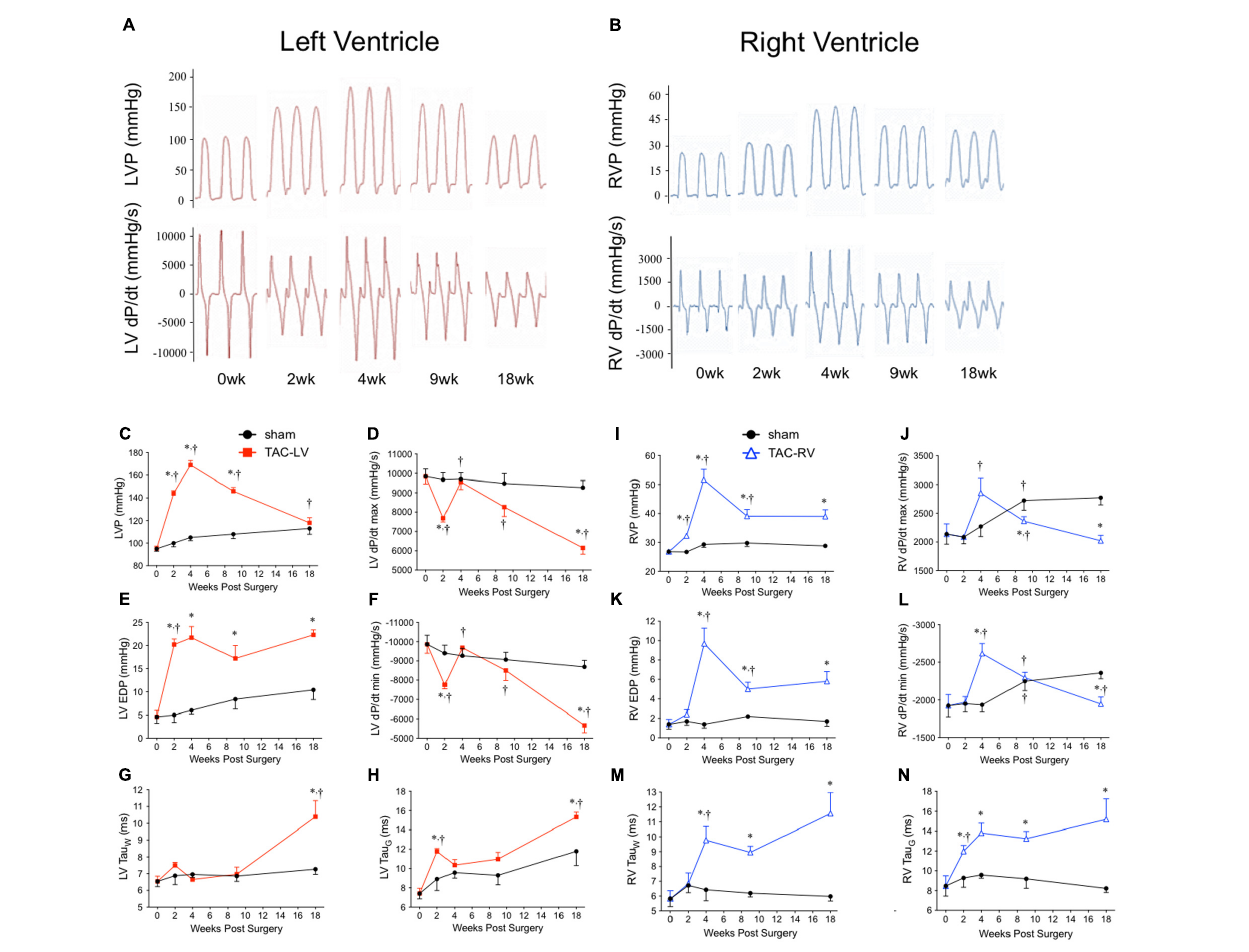
FIGURE 1 | Hemodynamic characterization of the transverse aortic constriction (TAC) model in male CD1 mice over 18 weeks. Left panel (red) = left ventricular (LV) function. Right panel (blue) = right ventricular (RV) function. Representative hemodynamic tracings over 18 weeks from (A) the LV and (B) the RV. (C) Peak LV pressure (LVP), (D) LV dP/dt max , (E) left ventricular end diastolic pressure (LV EDP), (F) LV dP/dt min , (G) Tau (Weiss), and (H) Tau (Glantz) profile the temporal changes in LV hemodynamics over 18 weeks of TAC. (I) Peak RV pressure (RVP), (J) RV dP/dt max , (K) right ventricular end diastolic pressure (RV EDP), (L) RV dP/dt min